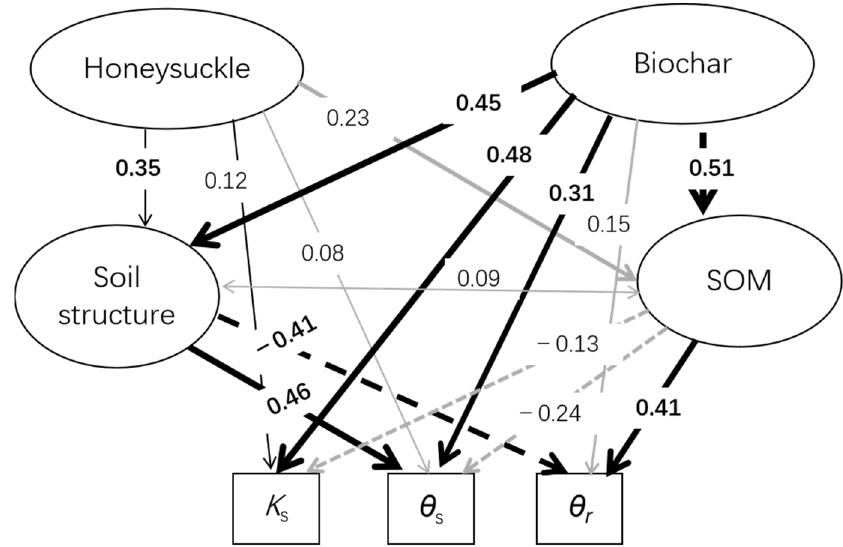
Figure 6. Results of SEM path analysis. Arrows represent the directionality of influence, with negative relationships represented by a dashed line. Black indicates a significant relationship ( p < 0.05) and grey represents an insignificant relationship ( p > 0.05). Thicker lines represent stronger